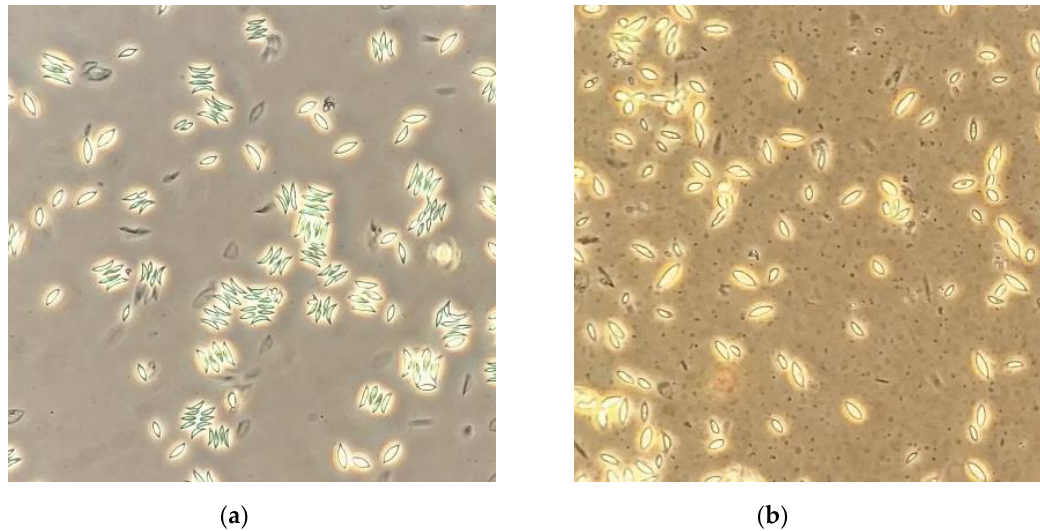
Figure 4. Scenedesmus obliquus observed under an inverted optical microscope after five days of cultivation: ( a ) with no surfactant added and ( b ) with Saponin at 100 CMC.